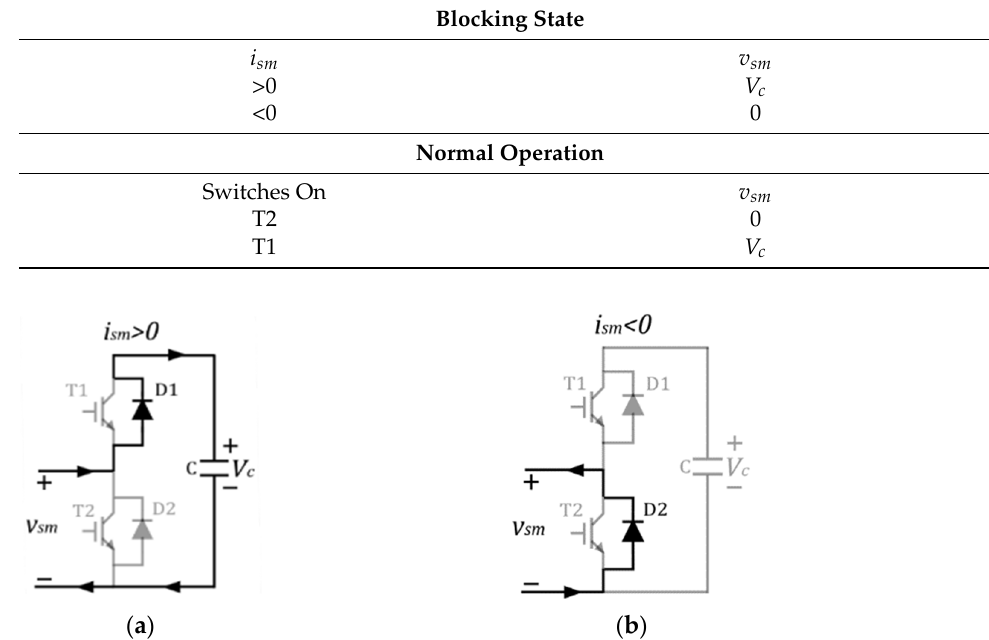
Table 1. HBSM Switching States.